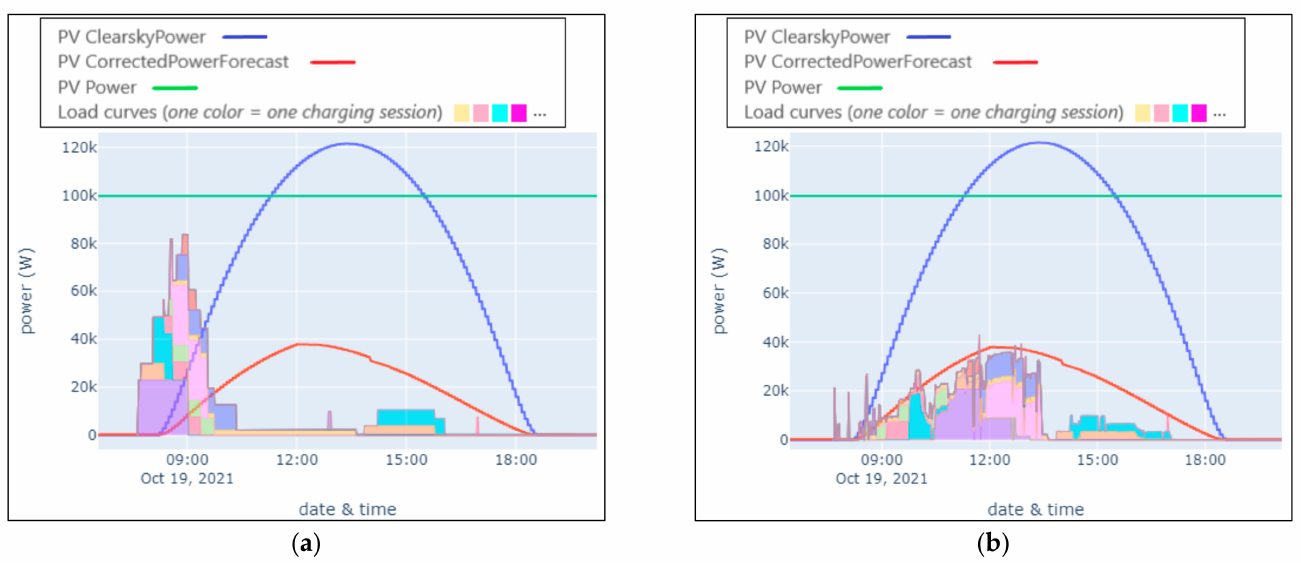
Figure 4. Results of 19th October 2021: ( a ) Stacked energies without control. The self-production rate SP u is equal to 34%; ( b ) stacked energies with control. The self-production rate SP is equal to 90%.